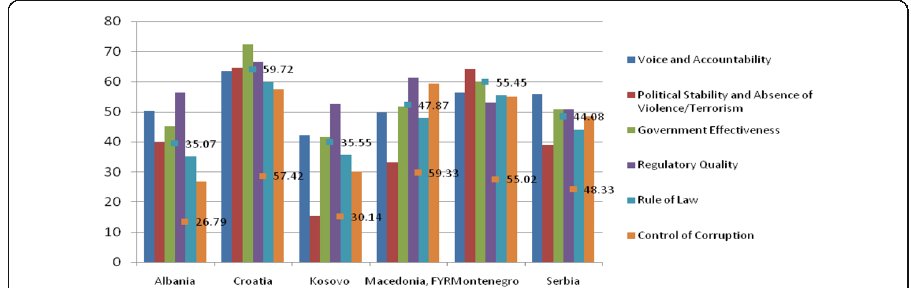
Fig. 4 Six indicators of institutional quality — Kosovo and comparator countries. Source: The World Bank, the Worldwide Governance